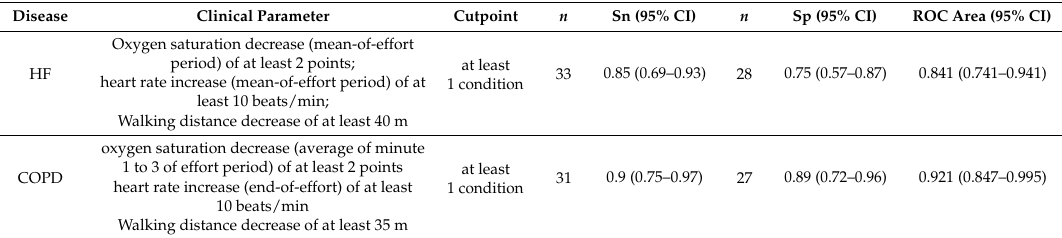
Table 4. Diagnostic performance of the developed clinical